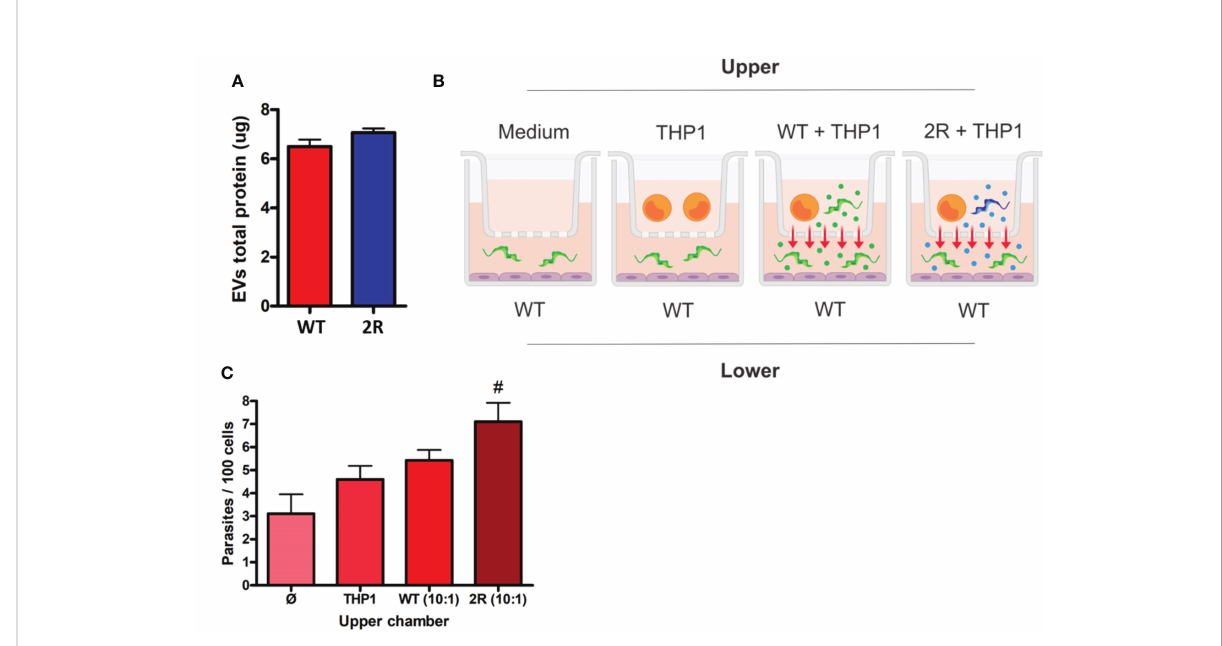
FIGURE 3 (A) Protein dosage of EVs secreted by METAs in the interaction with THP-1 cells (5 parasites for each cell). (B) Schematic representation of the Transwell assay. Two chambers are separated by a membrane with 0.45 µm porosity. In the lower chamber, an invasion test is performed that receives EVs from the upper layer. (C) Invasion rates of WT METAs to Vero cells during the Transwell assay. The x -axis labels indicate what was placed in the upper chamber of the Transwell plate. # indicates p < 0.01 in comparison to control (only medium in the upper chamber — Ø